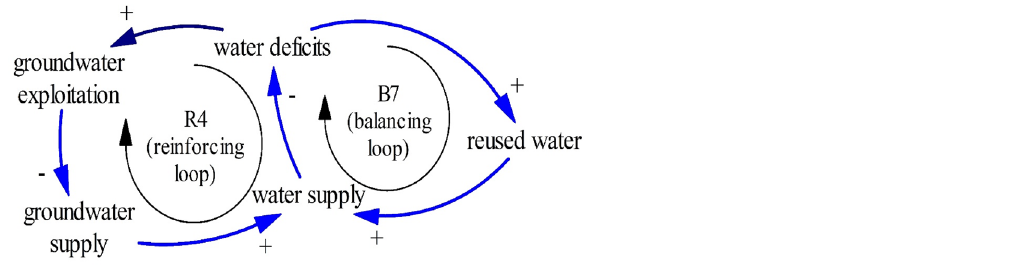
Figure 17. The Limits to Growth